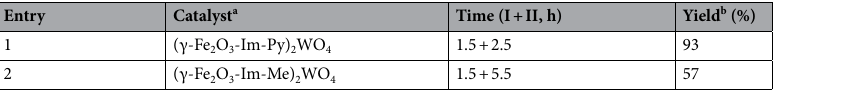
Table 8. The effect of different catalysts in the synthesis of 2-benzylidenemalononitrile from benzyl alcohol. a Amount of the catalyst is based on W content and relative to benzyl alcohol. b Reaction conditions: (I)